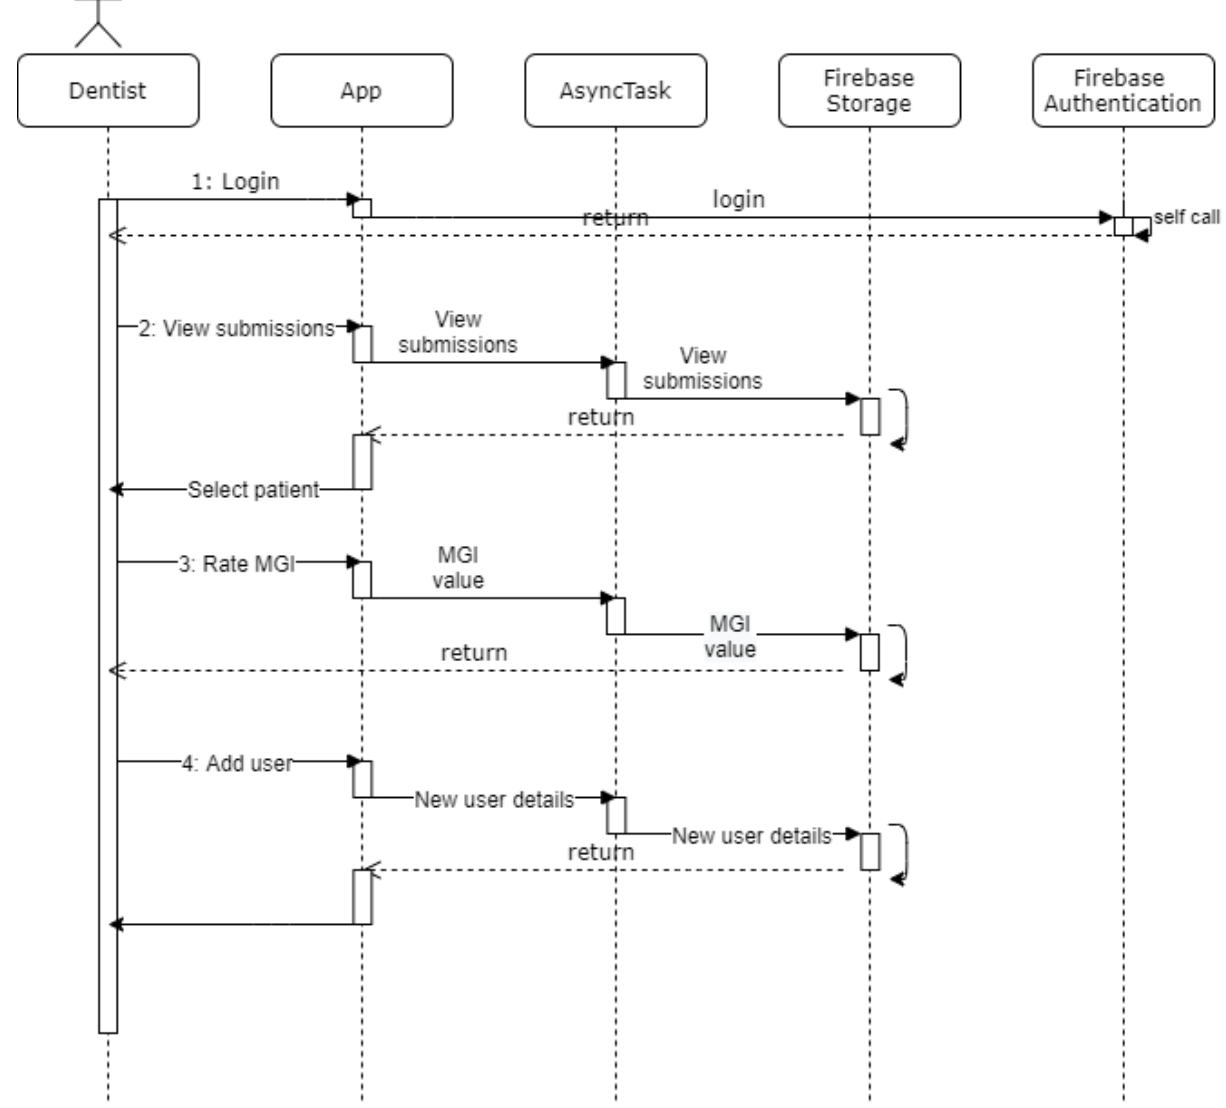
Figure 23. Sequence diagrams of the dentist side. After login the dentist can view patient submissions, rate gum status according to the MGI, add new patient and new